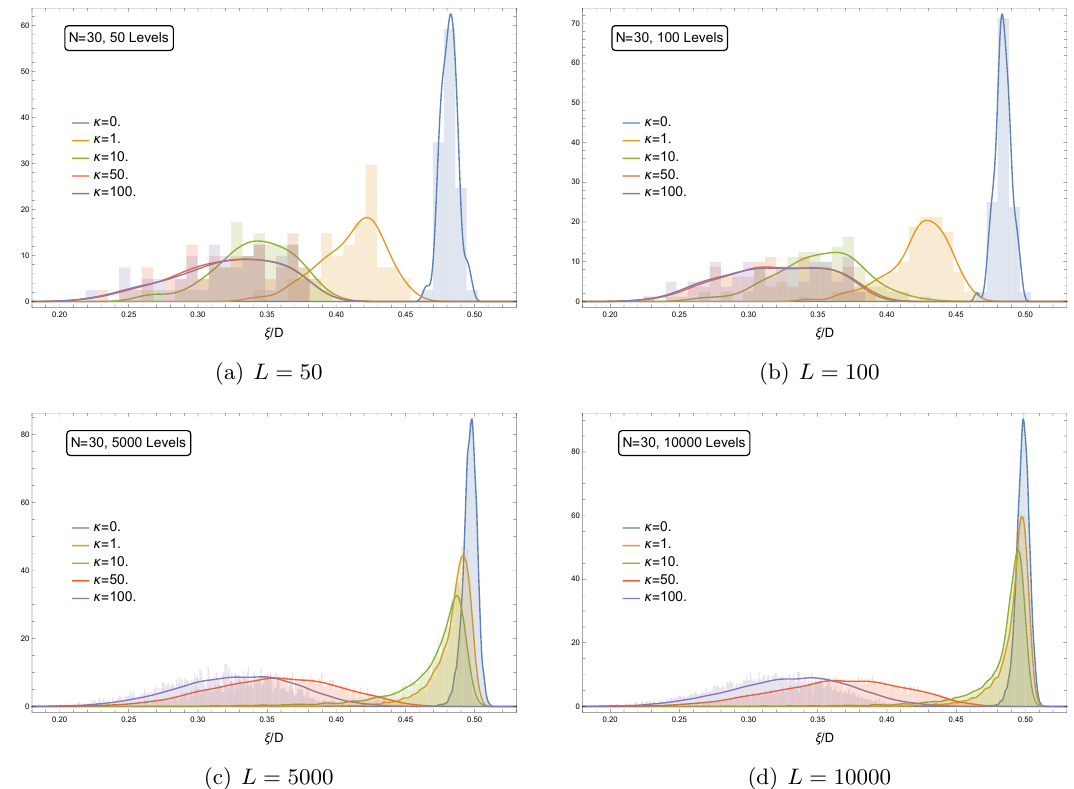
Figure 10 . The distribution of the IPR of the subsectors of the spectra including L levels starting from the ground state of the even parity sector ( D = 2 14 ) of N = 30 SYK model with (cid:20) = 0 ; 1 ; 10 ; 50 ; 100 ( L = 50 ; 100 ; 5000 ;